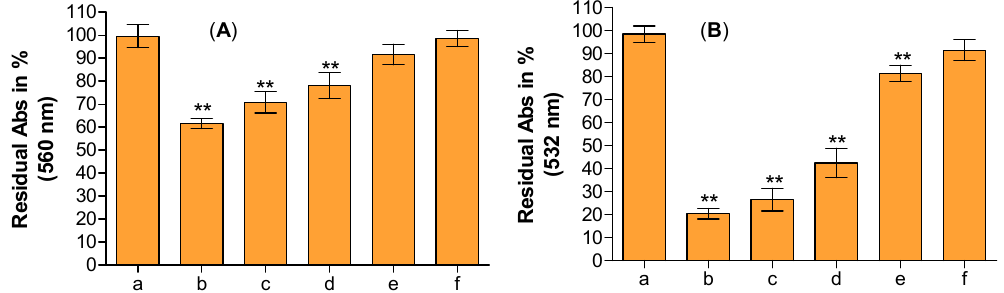
Figure 2. Superoxide anion ( A ) scavenging assay in the absence (a) or in the presence of 60, 30, 15, 7.5, and 3.7 µ g/mL of HEO (b–f, respectively); Hydroxyl radical ( B ) scavenging assay in the absence (a) or in the presence of 15, 7.50, 3.75, 1.85, and 0.92 µ g/mL of HEO (b–f, respectively). The asterisks (**) indicate significant differences ( p < 0.05). Each value represents mean ± SD ( n = 3).